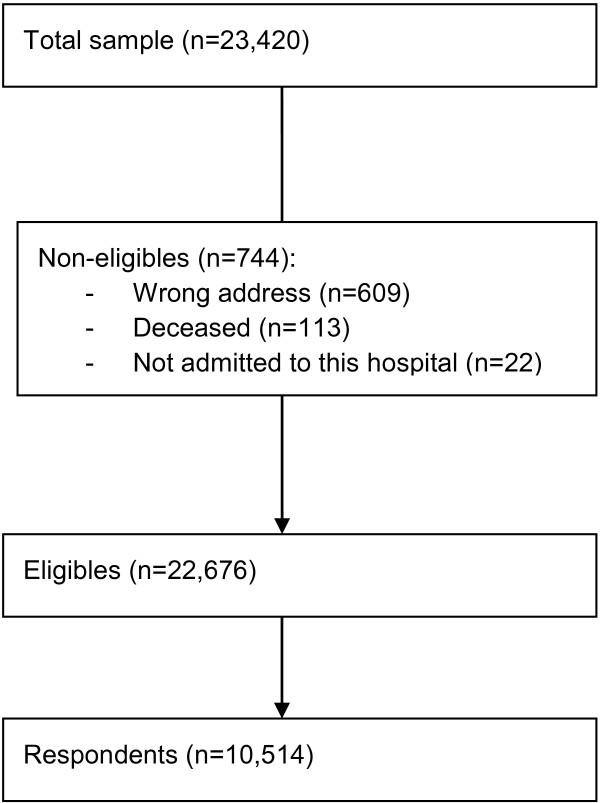
Survey flowchart.